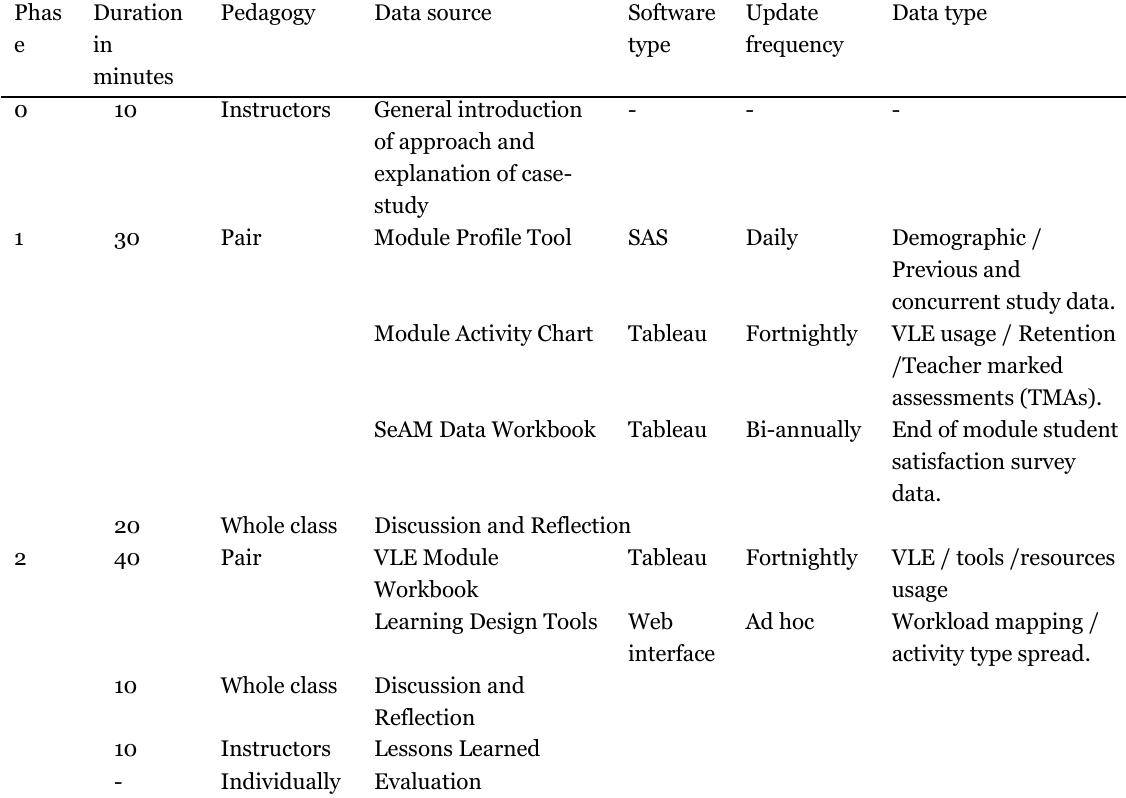
Design of A4AW Professional